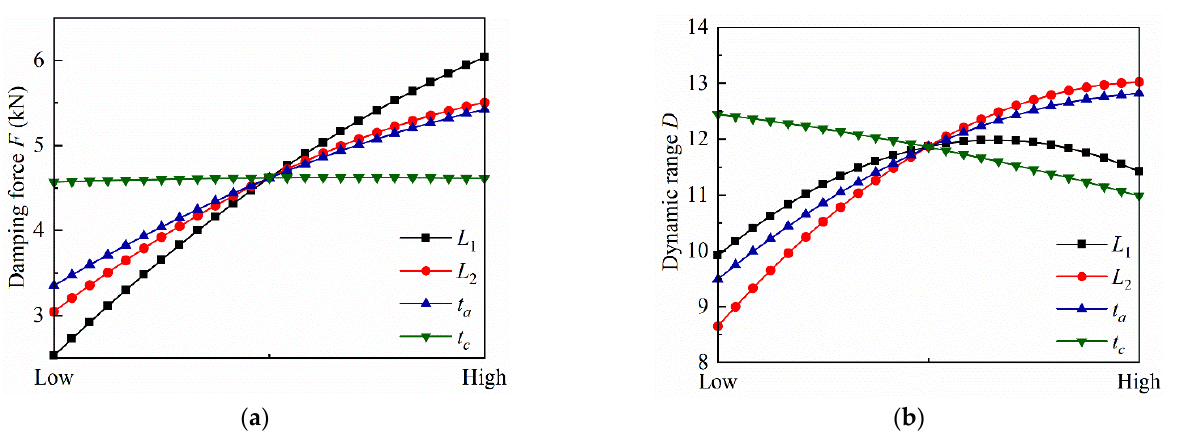
Figure 9. Main effect graph: ( a ) damping force; ( b ) dynamic range.